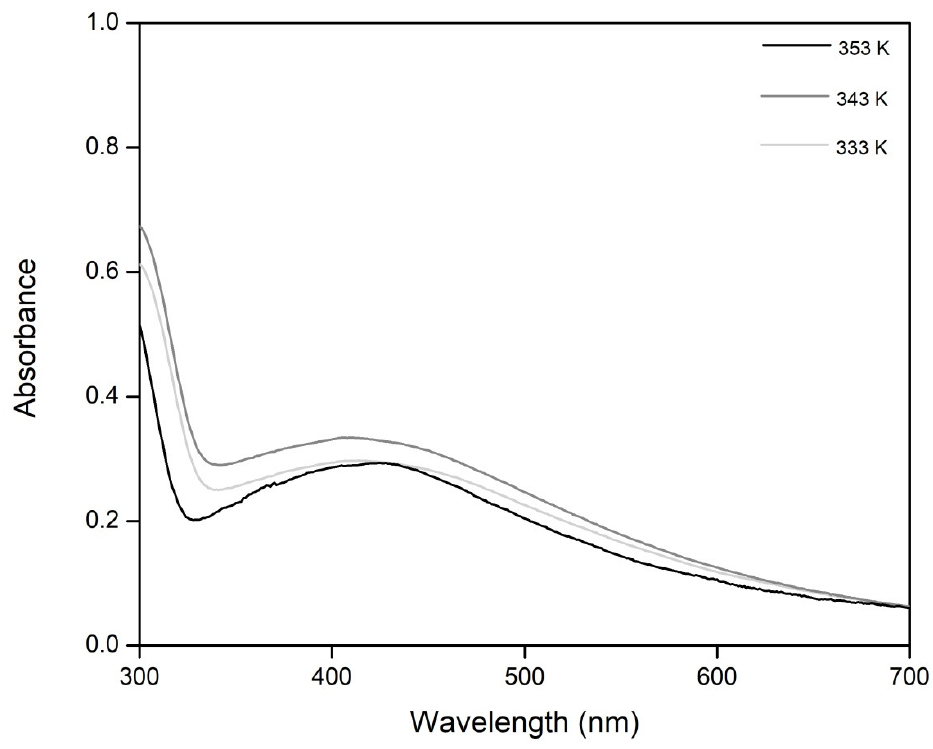
Figure 4. UV–VIS absorption spectra for different ultrasound bath temperatures.